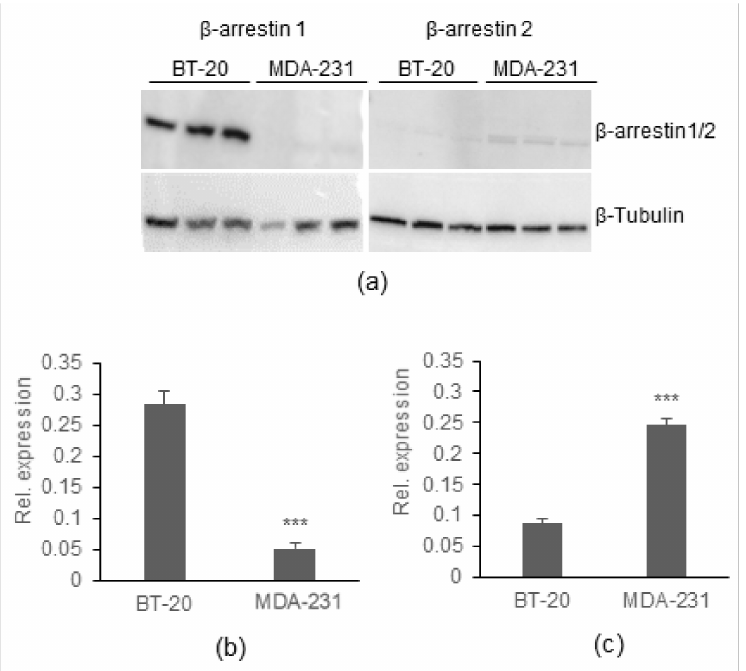
Figure 6. β -arrestin 1 and 2 are differentially expressed in BT-20 and MDA-MB-231 cells. Three inde- pendent batches of BT-20 and MDA-MB-231 cells were collected and analysed for β -arrestin 1 and 2 protein expression by Western blot. ( a ) Western blot image depicting β -arrestin 1, β -arrestin 2, and β -tubulin (housekeeping control) expression in BT-20 and MDA-MB-231 cells ( b ) Quantification (mean ± SEM) of the relative β -arrestin 1 expression ( c ) Quantification (mean ± SEM) of the relative β -arrestin 2 expression. *** p ≤ 0.001 (Student’s t -test) to compare expression of β -arrestin 1/2 in the different cell